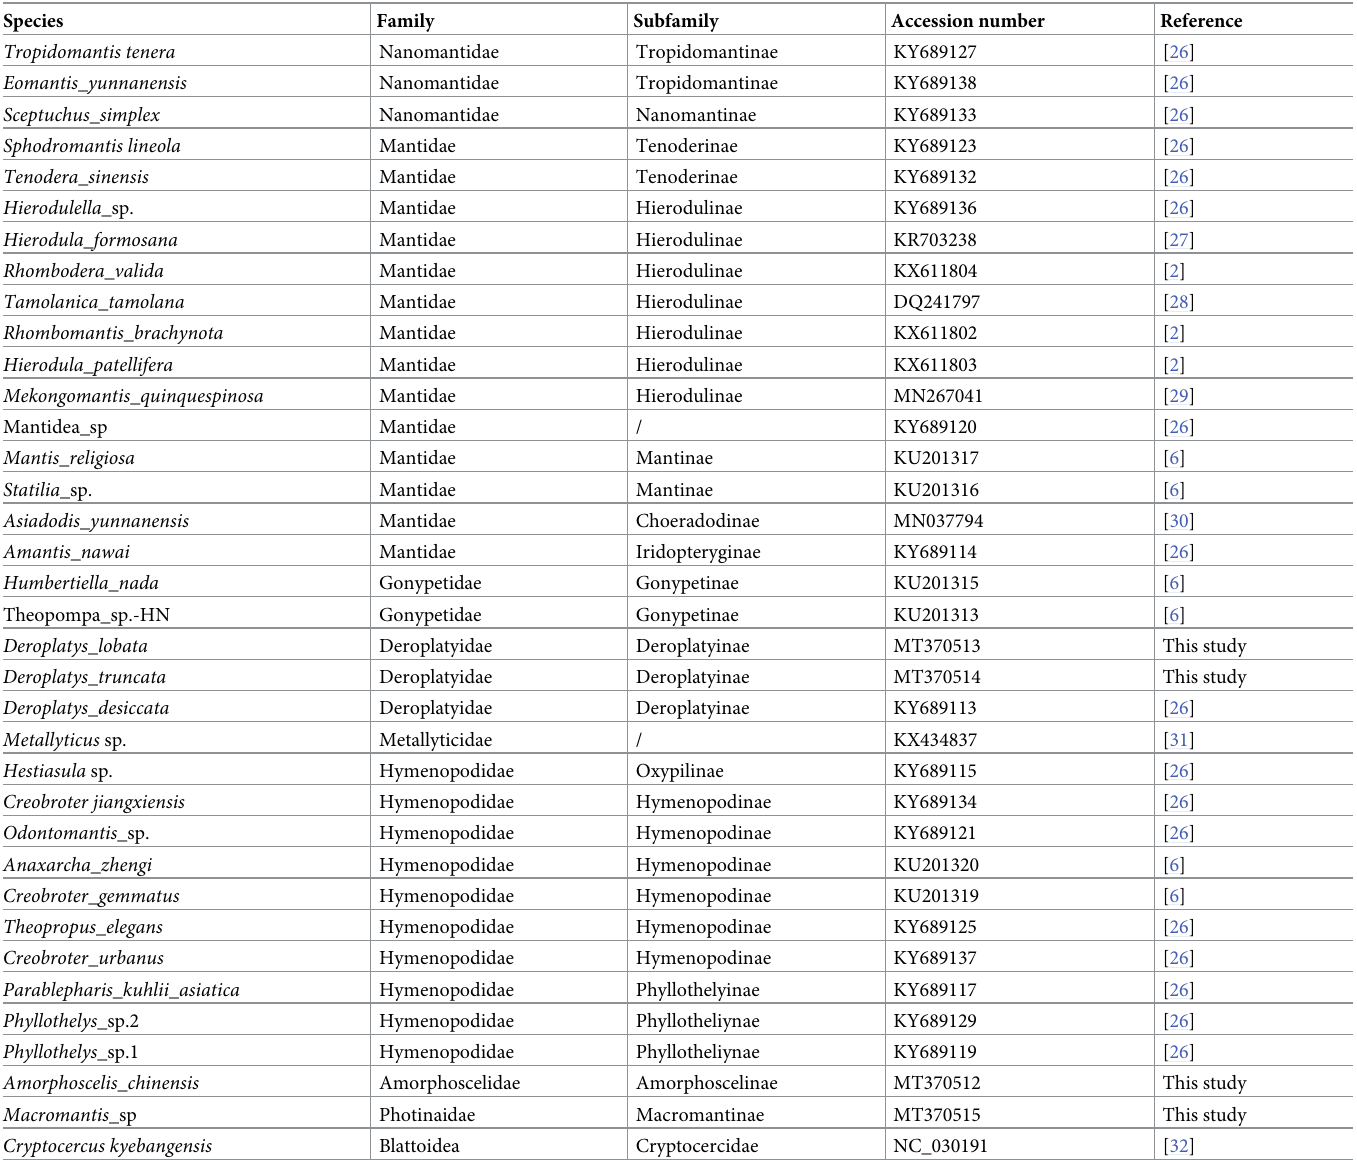
Table 1. The information of samples used in this